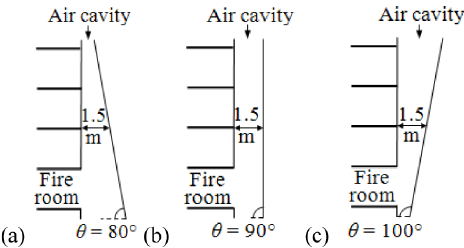
Fig. 3. Structure schematic diagram when (a) θ = 80°,